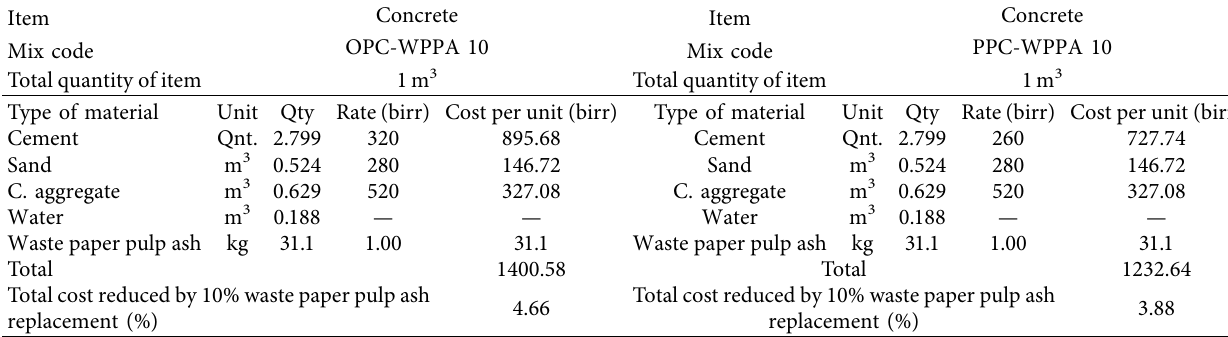
Table 18: OPC-WPPA 10 and PPC-WPPA 10.